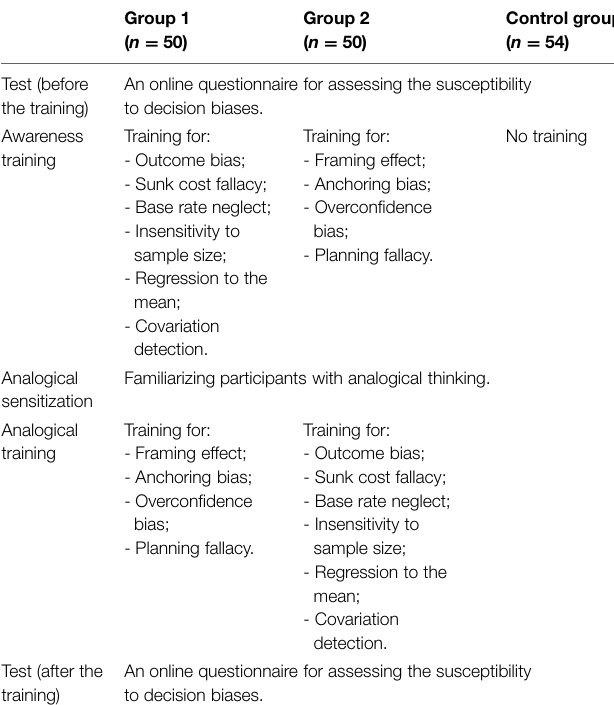
TABLE 1 | Overview of the experimental